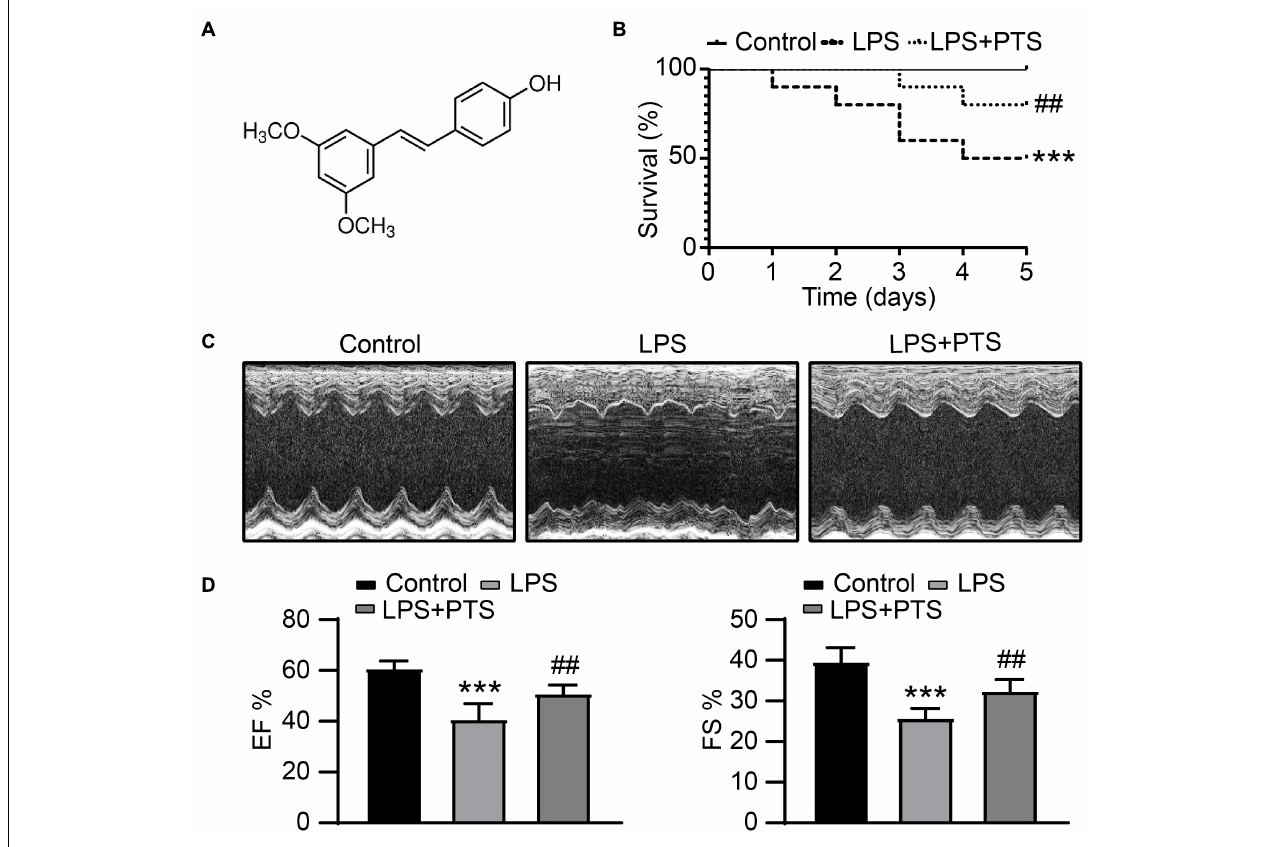
FIGURE 1 | PTS improved the survival rate and myocardial dysfunction in LPS-Induced septic mice. (A) The Structural formula of PTS. (B) Survival rate of the control group, LPS group, and LPS + PTS group ( n = 10). (C) Representative echocardiography of mice from control group, LPS group, and LPS + PTS group. (D) EF and FS% of mice from control group, LPS group, and LPS + PTS group were measured by echocardiography ( n = 6). *** P < 0.001 control vs. LPS, ## P < 0.01 LPS vs. LPS +